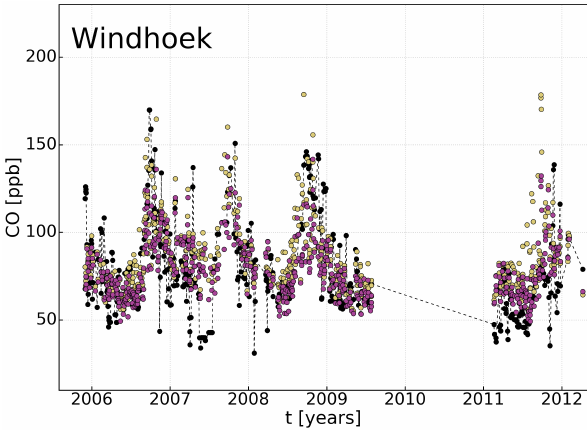
Figure 6. As Fig. 5, but for